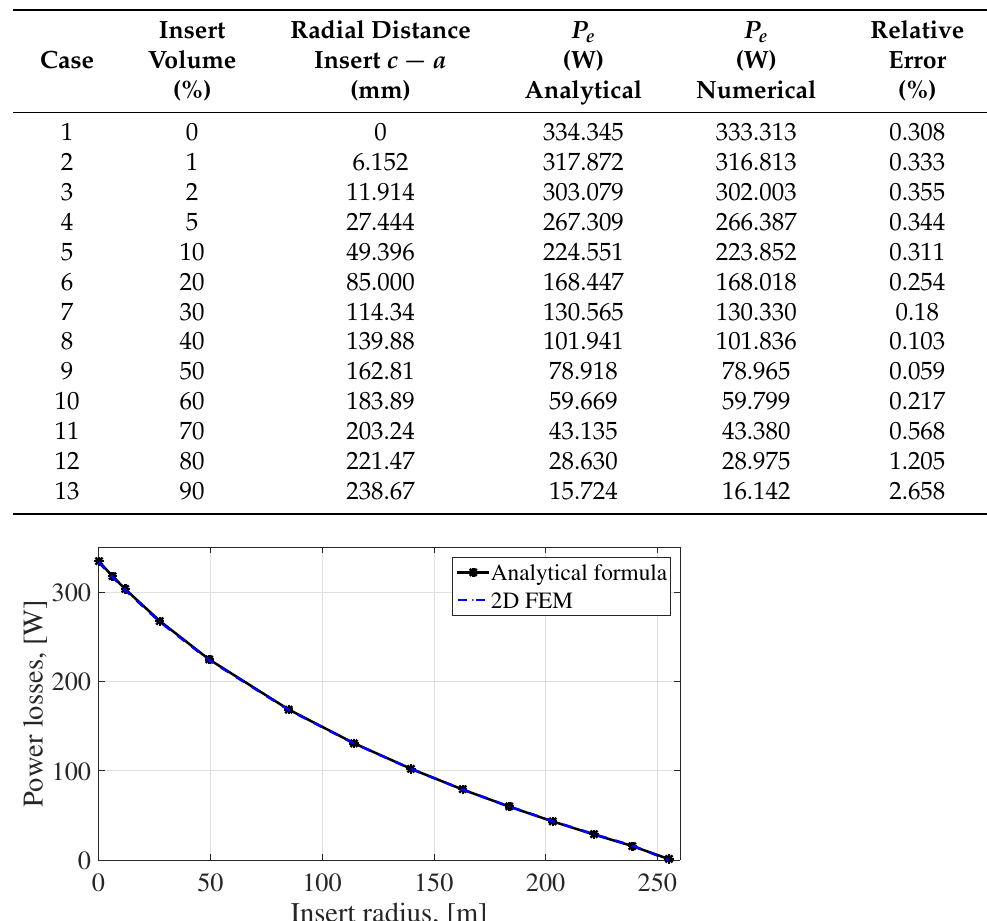
Figure 6. Power losses for different SSI